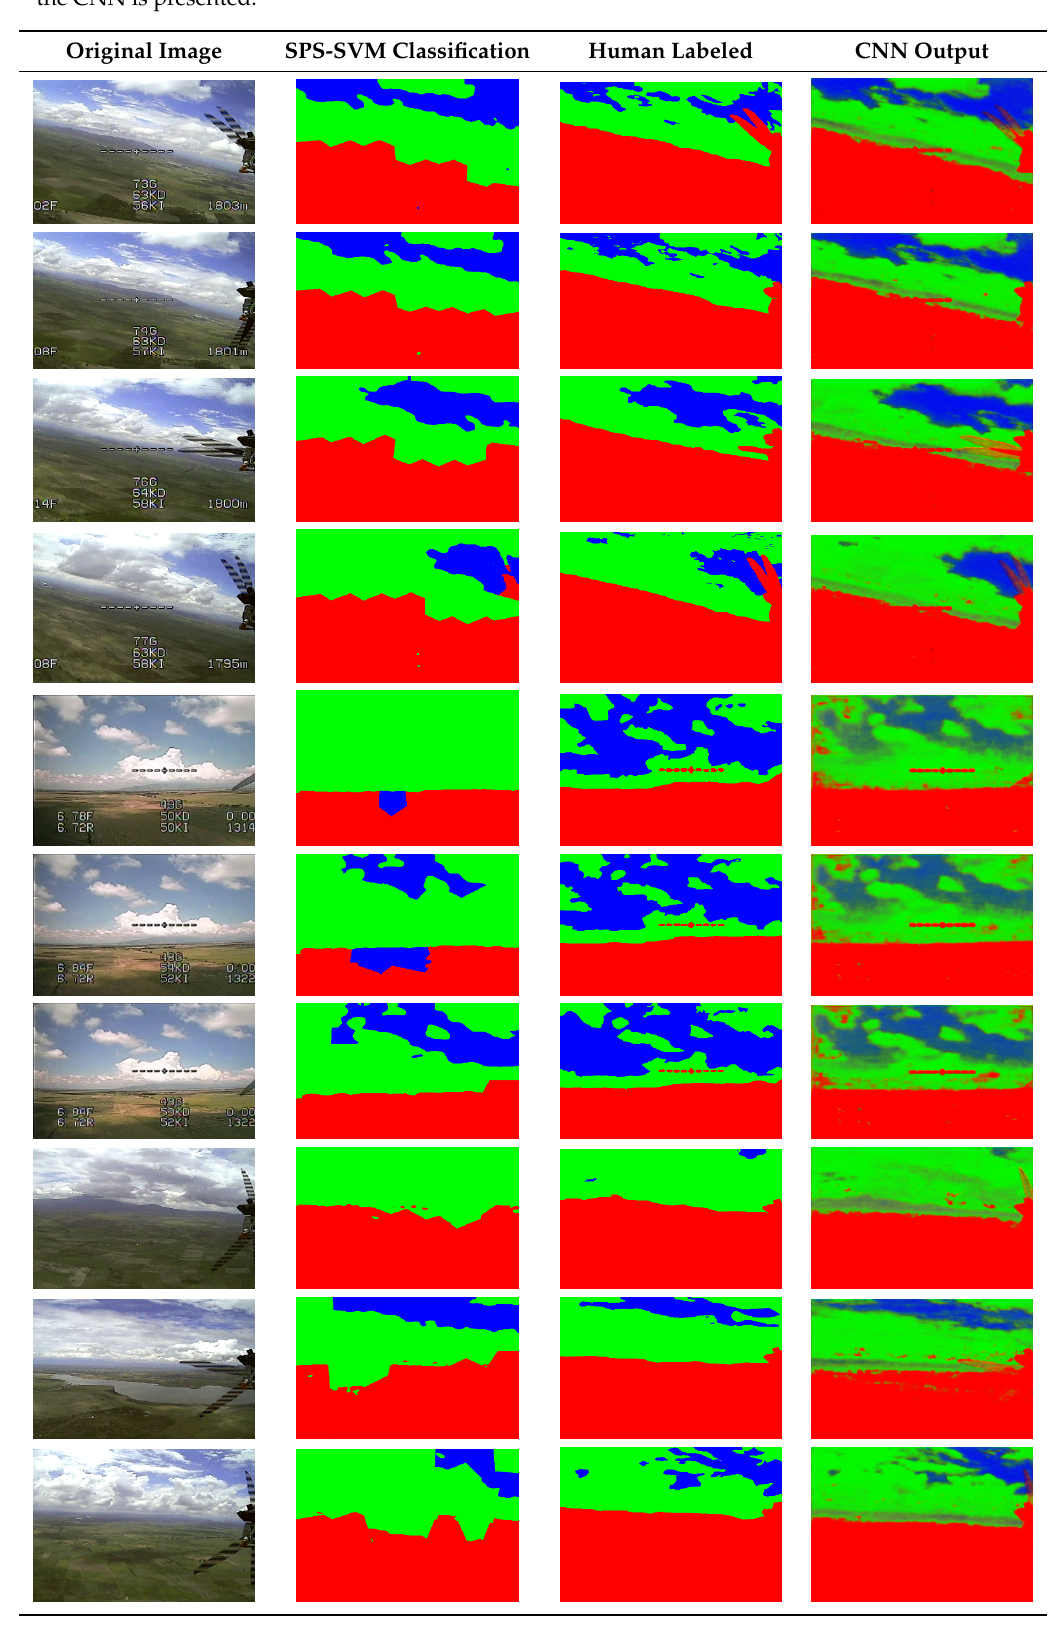
Table 1. Test results. The first column shows the original image. The second column shows the Superpixel Segmentation (SPS)–Support Vector Machine (SVM) classification. The ground truth, generated by a human is shown in the third column. In the fourth column, the classification made by the CNN is